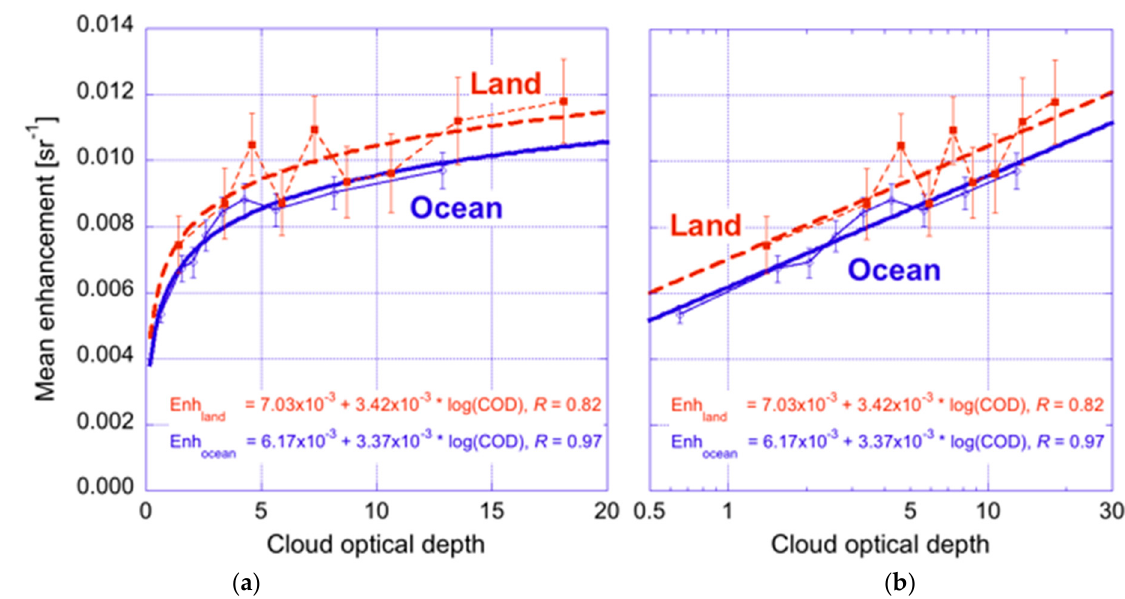
Figure 4. Mean near-cloud enhancement in vertically integrated lidar backscatter, plotted as a function of maximum cloud optical depth (COD) of nearby clouds. The near-cloud enhancement is calculated as the difference between the mean vertically integrated lidar backscatters 1-2 km and 10-15 km from clouds. The enhancement is plotted for ten 10%-wide percentile ranges of the “nearby cloud” COD distribution (with the leftmost symbol representing the thinnest 10% of clouds, etc.). Thin lines connect the data points, thick lines represent a logarithmic fit to the data. ( a ) Linear COD scale; ( b ) Logarithmic COD scale. (Data used are available at Table S5)